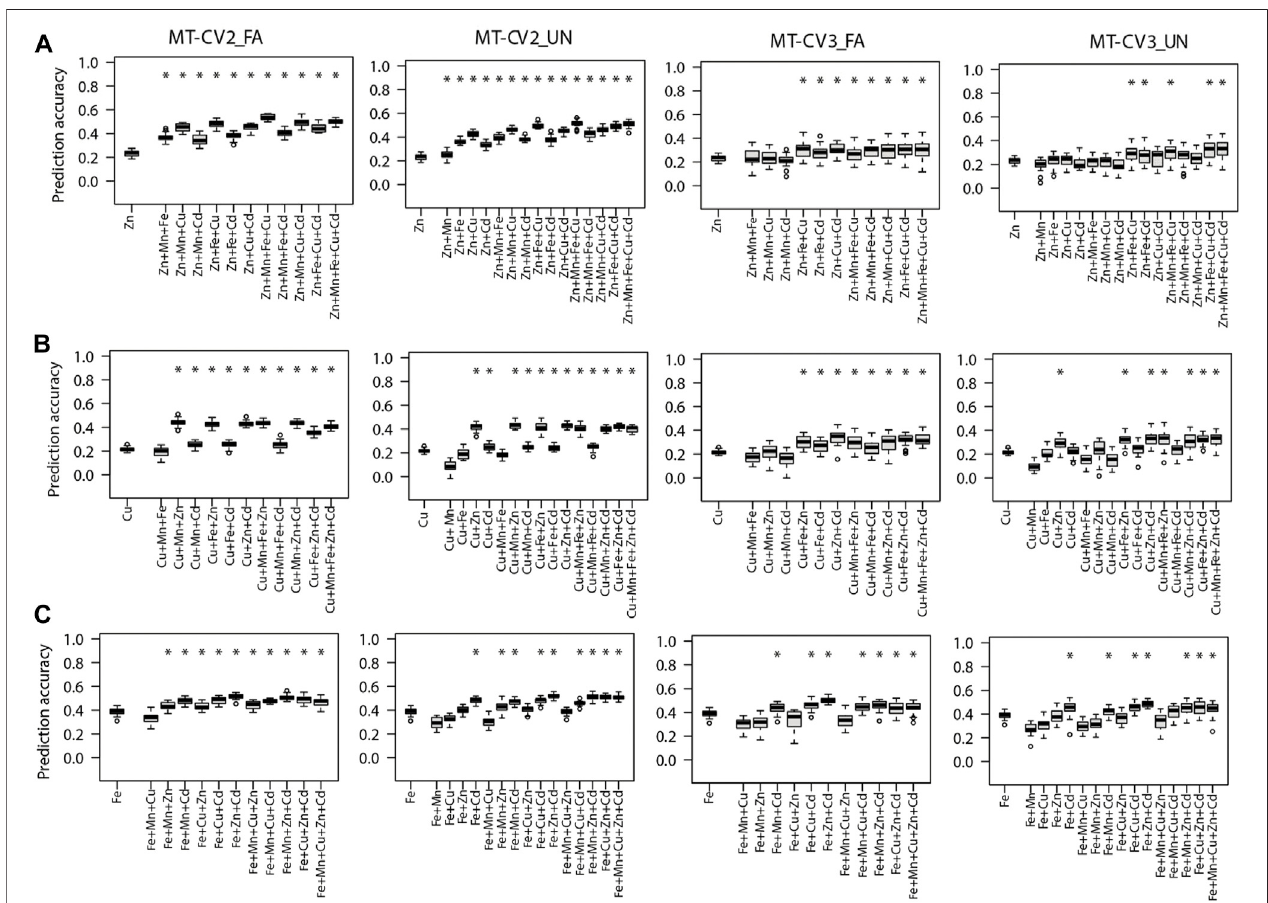
FIGURE 3 | Genomic prediction accuracies of the genotype-based single trait (ST) model (ST-GBLUP) and multi-trait (MT) models (MT-FA and MT-UN) under differentcross-validation(CV)schemes(ST-CV1,MT-CV2,andMT-CV3).Thetargettraitsare (A) Zn, (B) Cu,and (C) Fe.The fi rstbox-whiskerineachportrayalindicates the accuracies of the ST-GBLUP model in the ST-CV1 scheme. Other box-whiskers refer to the accuracies achieved by MT models with different trait combinations. Asterisks above box-whiskers indicate that the prediction accuracies of the MT model for the speci fi c trait combination were statistically signi fi cantly ( p < 0.05, t -test) higher than those of the ST-GBLUP